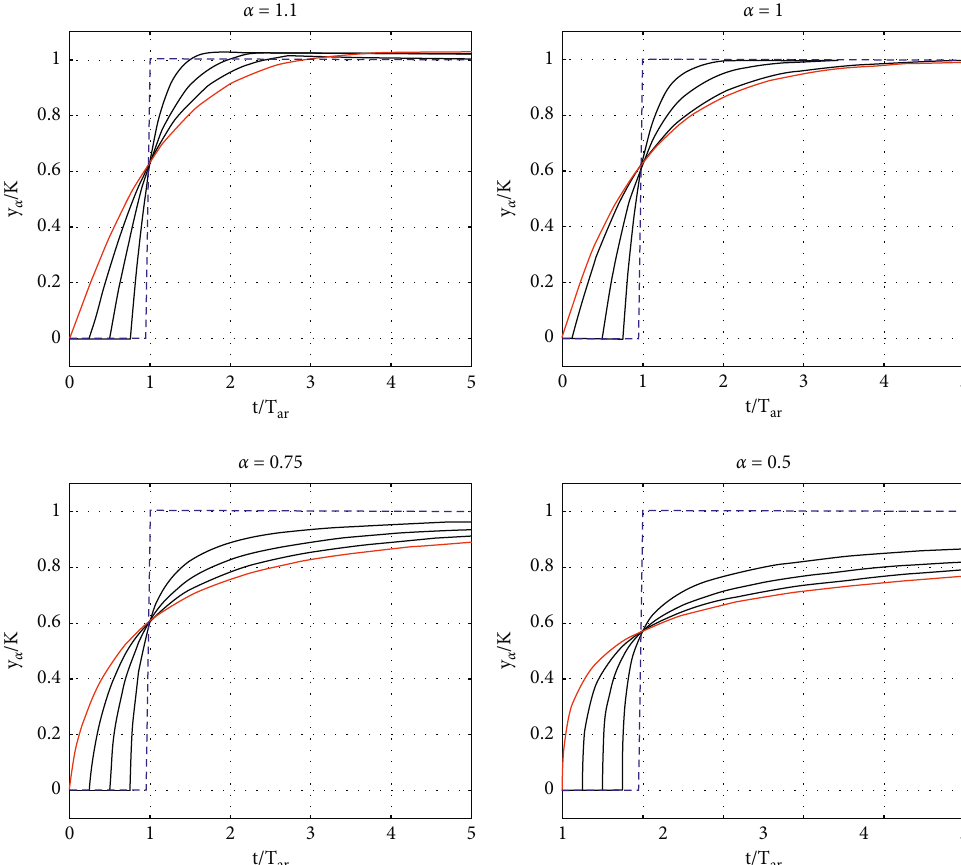
Figure 2: Normalized step responses y α /K of FFOPDT model (14) for different values of the fractional-order α and different values of the normalized dead-time τ . The normalized dead-times are τ � 0 (red), 0.25, 0.5, 0.75, and 1 (blue). Notice that time is normalized with respect to the average residence time T ar .